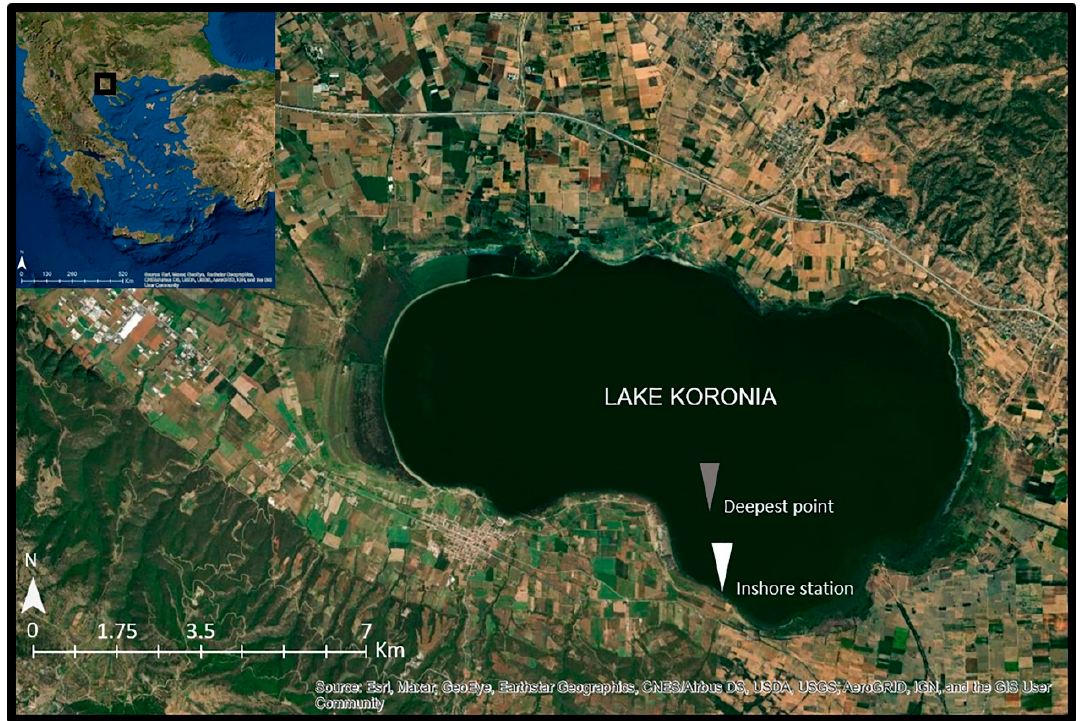
Figure 1. Map of Lake Koronia showing the location of the sampling station at the deepest point (gray point) and the inshore station (white point).